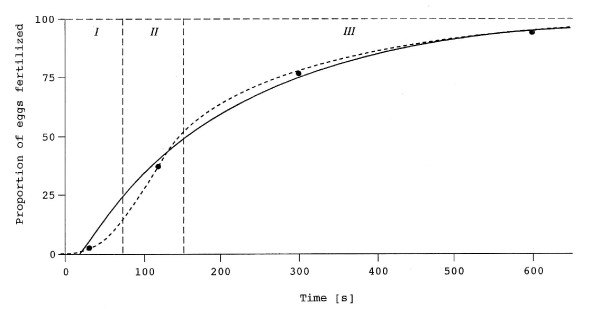
Potential fertilization curves based on the medians (dots) of the experimental fertilization durations (see Fig. 1 white bars). The saturation curve (solid line) assumes instantaneous activation of the sperm after ejaculation, whereas the sigmoid curve (dashed line) assumes that sperm motility starts continuously after sperm release. For a description of the three phases I – III, see the text.